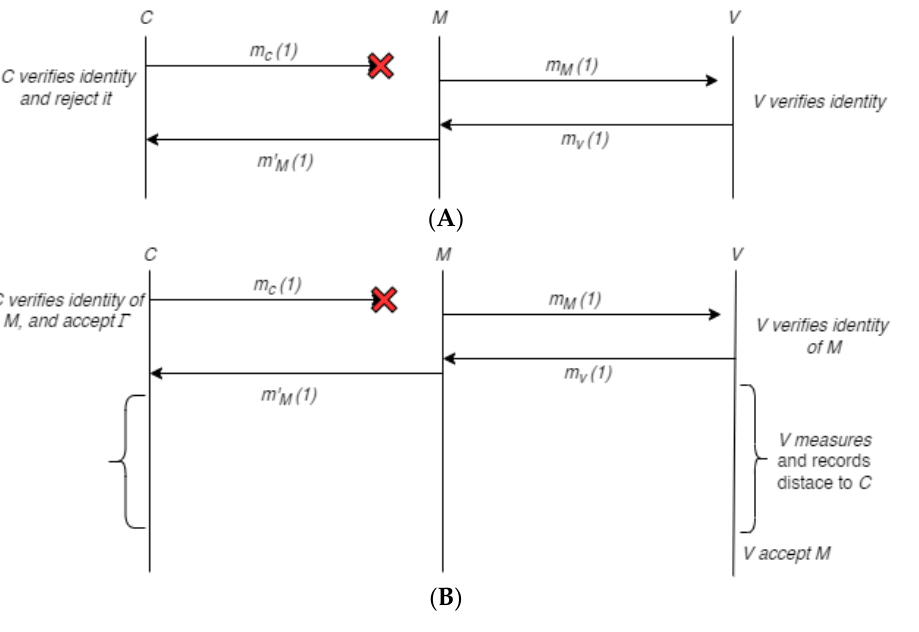
Figure 10. An assault by the MiTM. ( A ) C is familiar with ID V and pk V , ( B ) C does not know who the verifier is.